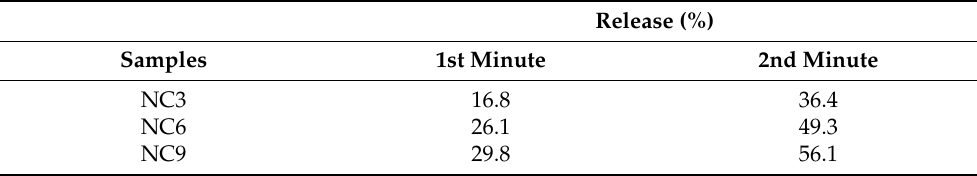
Table 2. The release of orange peel oil from three WPC–pectin complex powders in the simulated salivary